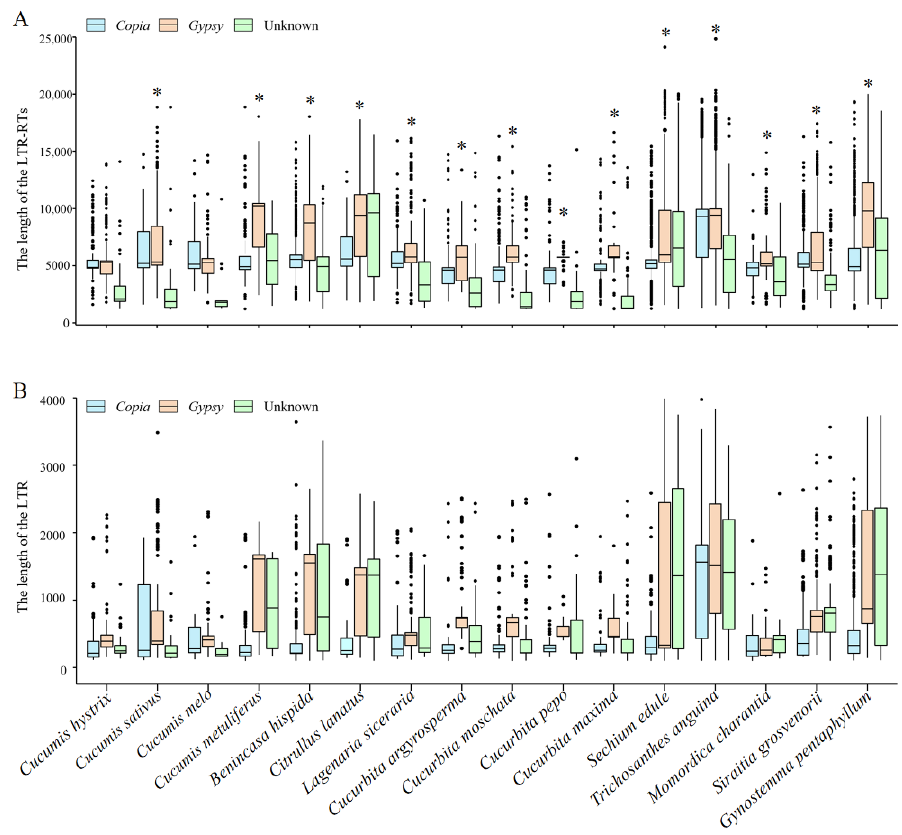
Figure 2. Length of the full-length LTR-RTs ( A ) and their LTRs ( B ) in Cucurbitaceae species. The asterisks (*) denote the 14 species with the average length of the Gypsy elements larger than that of the Copia and Unknown elements.